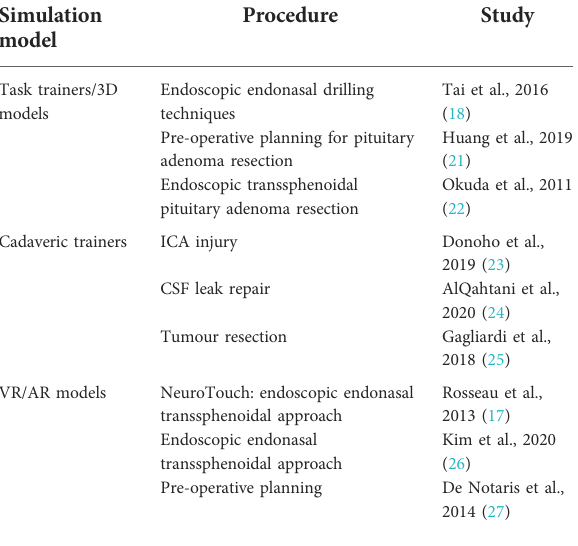
TABLE 3 Examples of current simulation models for the endoscopic endonasal approach. Simulation